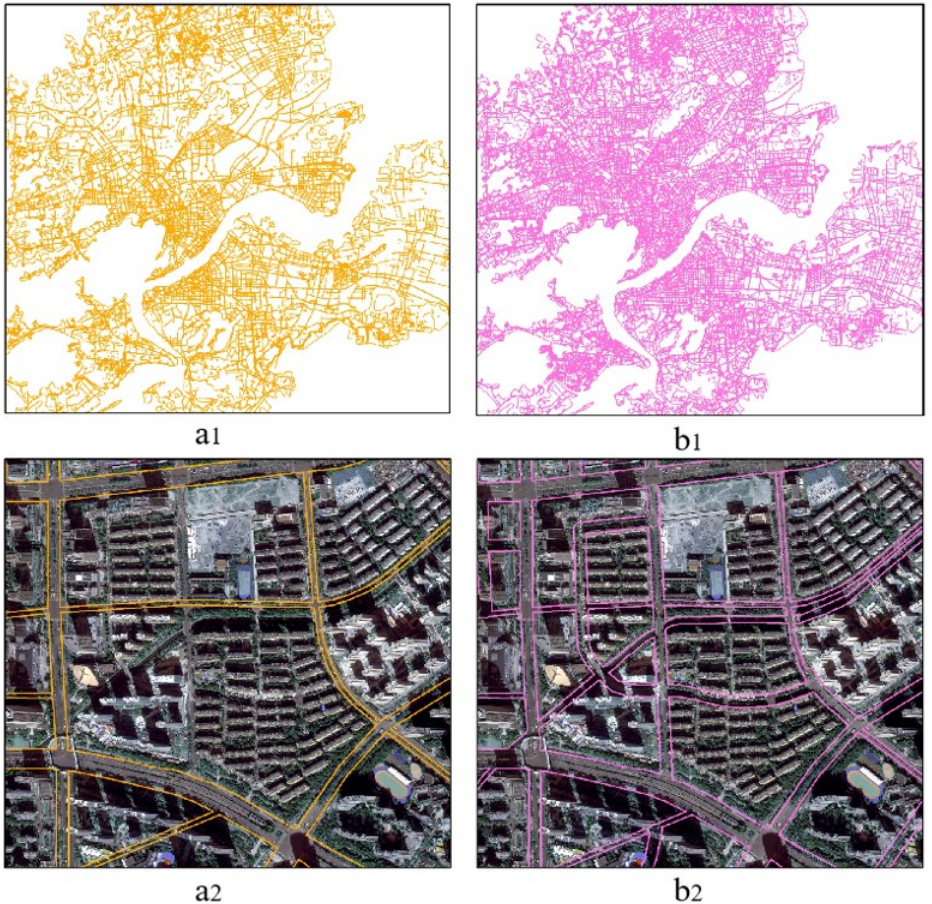
Figure 2. ( a1 ) The example of parcel segmentation for EULUC; ( a2 ) The example of parcel image for EULUC; ( b1 ) The example of parcel segmentation for this study; ( b2 ) The example of parcel image for this study.